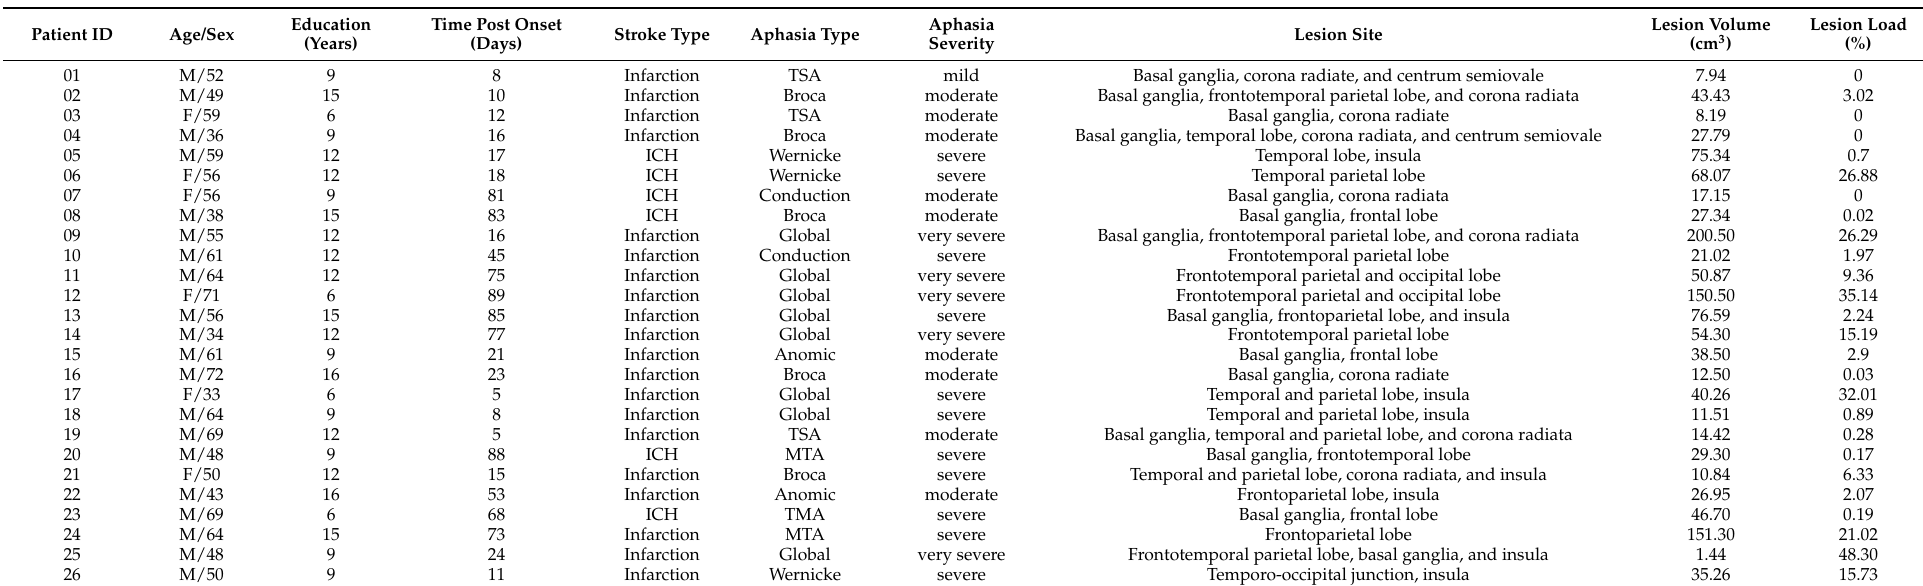
Table 1. Demographic and general clinical characteristics of the